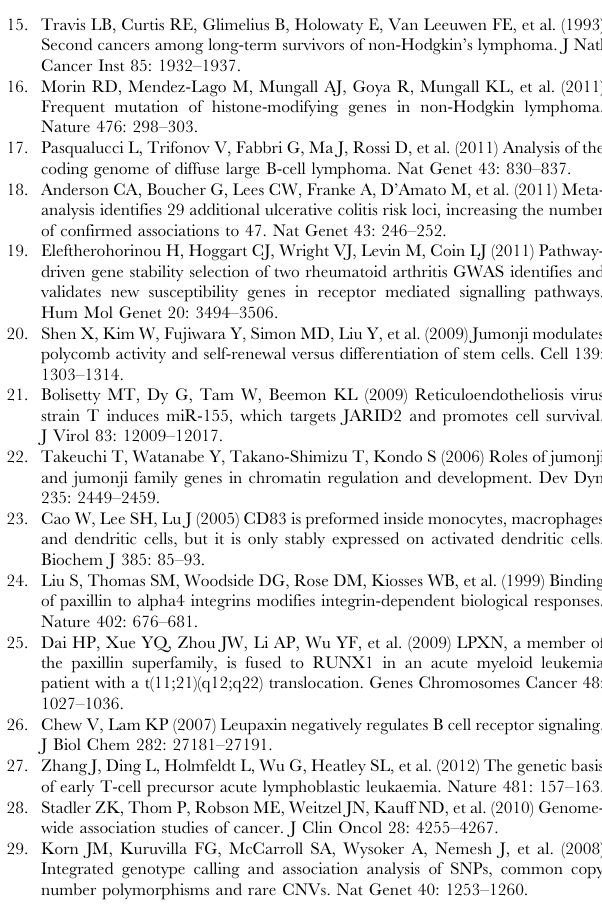
Figure S5 Overlap and distinct SNPs (A) and genes (B) amongst each category of LYM, NHL, FL, DLBCL. Top 100 genes from each gene-enrichment analysis and the SNPs with p , 1.0 6 10 2 3 were used for comparison. Figure S6 Pedigrees of two representative families with familial lymphoproliferative syndrome included in our stage-1. (LPS, defined as two or more lymphoid cancers in the same parental lineage), showing occurrence of multiple subtypes within the same individuals and the sibships. Lym-NOS = Lymphoma, not other- wise specified. Leuk = Leukemia. Figure S7 Principal component analysis (PCA) plot shows the overlap of cases and controls. The groups included are GAIN Bipolar controls (BPC), GENEVA Diabetes controls (DBT) and lymphoma cases (LYM). This PCA plot shows the Caucasian and Jewish clusters distinguished using the first two major PCs. PCA was done on a subset of LD pruned SNPs from the original dataset. The top four eigenvectors were used for adjusting population stratification in the association analysis. Analysis was done using EIGENSTRAT. Table S1 SNPs selected from the GWAS to perform replication. Table S2 Results of the replication phase (Stage-2).